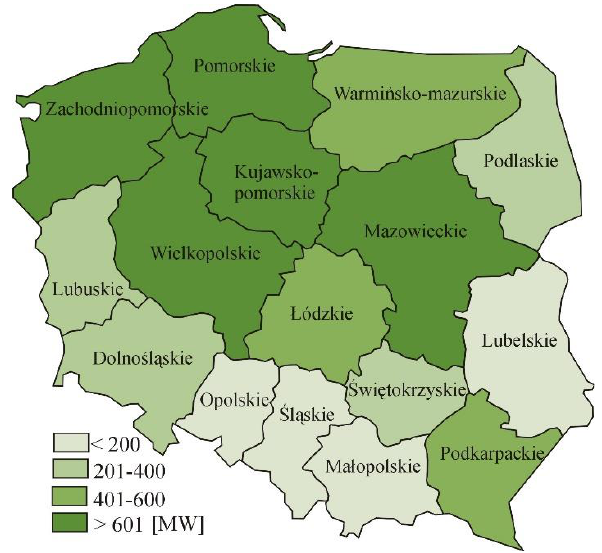
Figure 1. Capacity of RES in Poland (own study based on [47]).